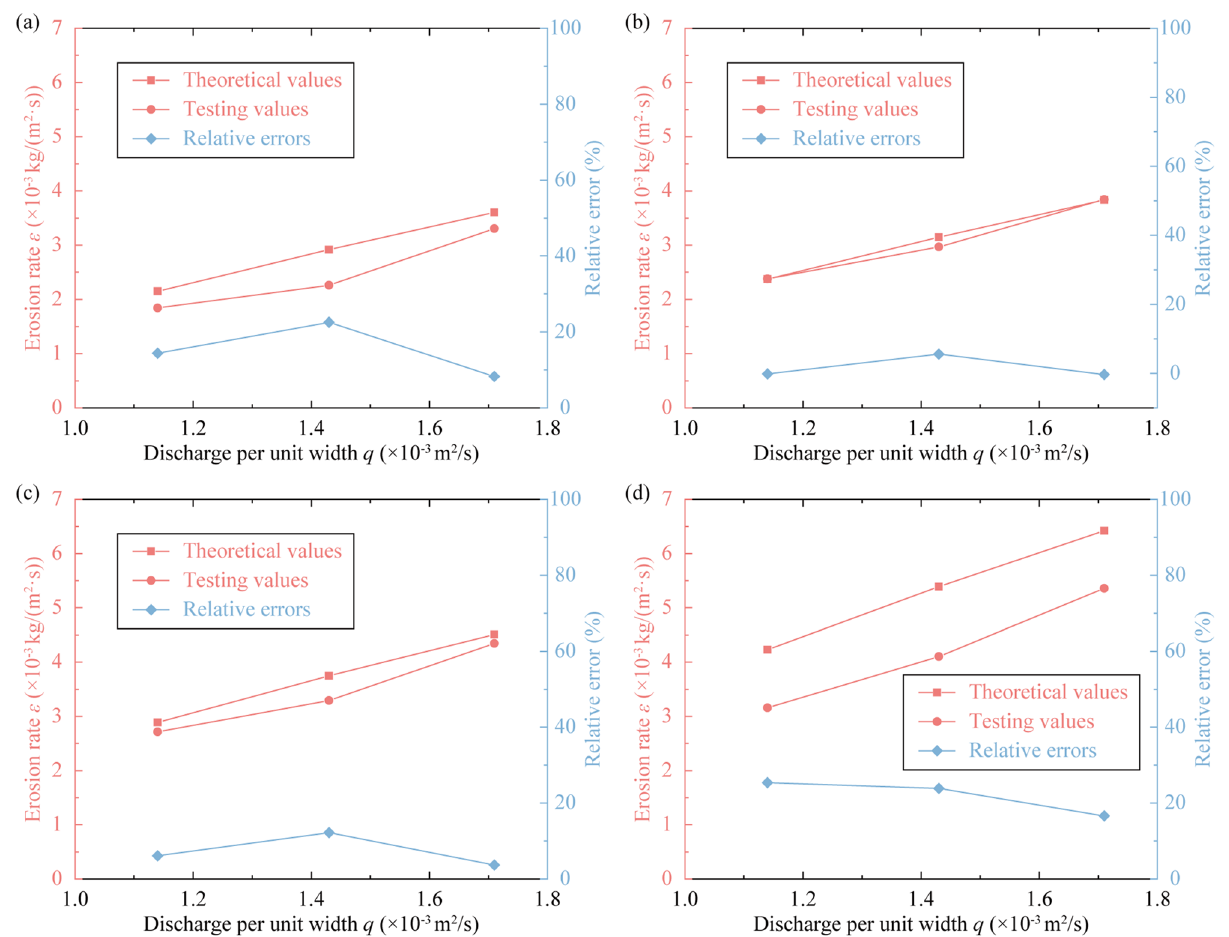
Figure 7. Comparison of theoretical and testing values of the erosion rate under different slope gradients: ( a ) θ = 26.6°, ( b ) θ = 29.7°, ( c ) θ = 33.7°, and ( d ) θ =